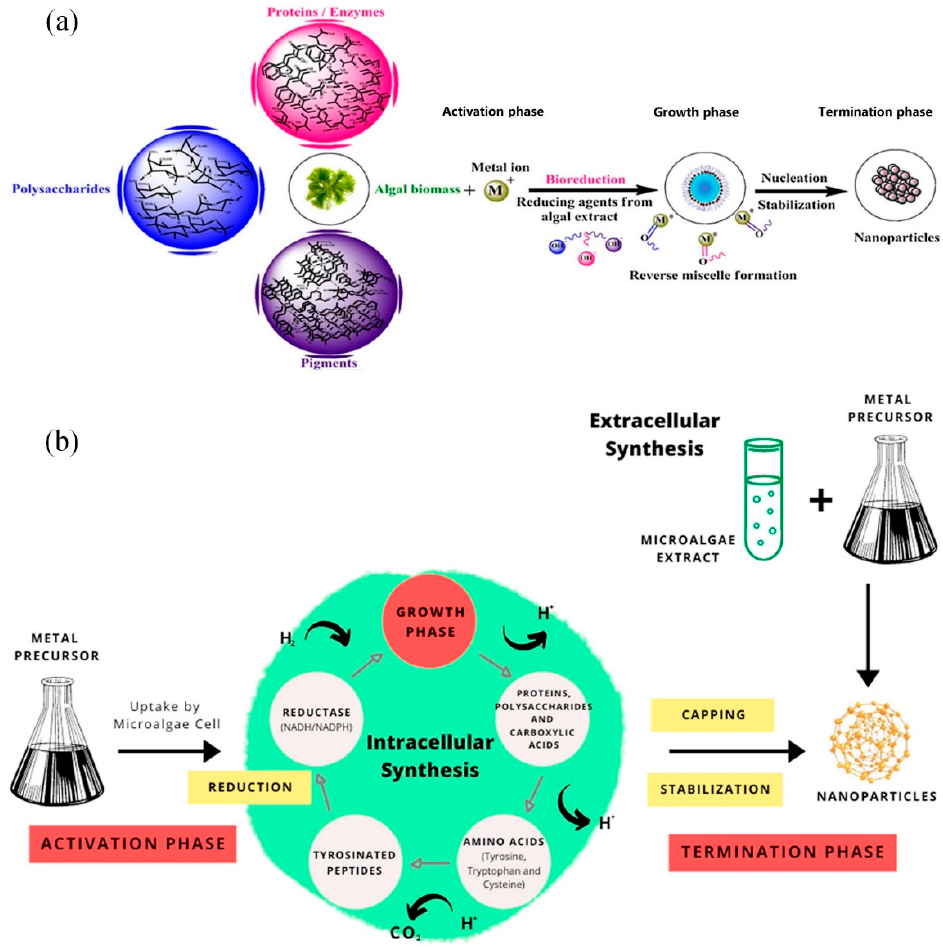
Figure 10. ( a ) General mechanism of the algae-mediated biosynthesis of metal nanoparticles Reprinted/adapted with permission from Ref. [55]. Copyright 2016, Elsevier. ( b ) Schematic diagram of the intracellular and extracellular synthesis mechanisms of algae-mediated nanoparticles. Reprinted/adapted with permission from Ref. [68]. Copyright 2020, Elsevier.